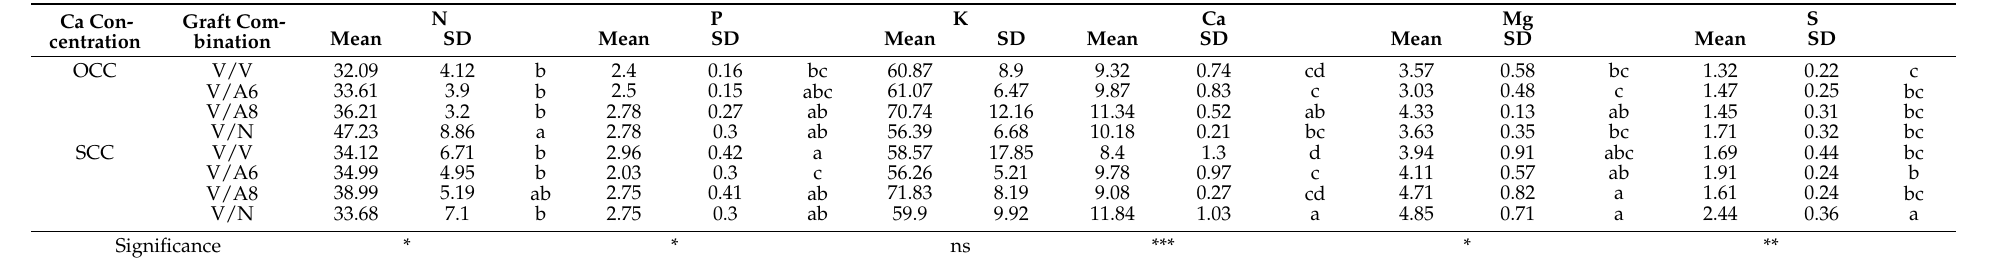
Table 2. Effects of calcium concentration and plant combinations on mineral composition (N total, P, K, Ca, Mg and S—g/kg DW) of pepper leaves at the end of the experiment (98